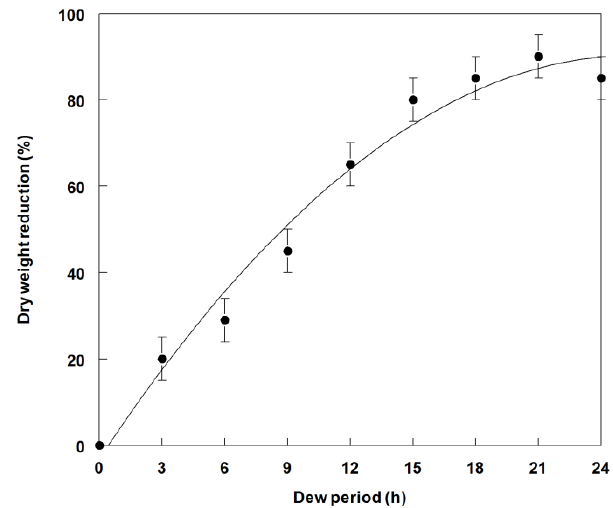
Figure 5. Effect of dew period duration on dry weight reduction of spreading dayflower inoculated with P. commelinicola at 1.0 × 10 8 under greenhouse conditions. Error bars represent Fisher’s LSD ( p =